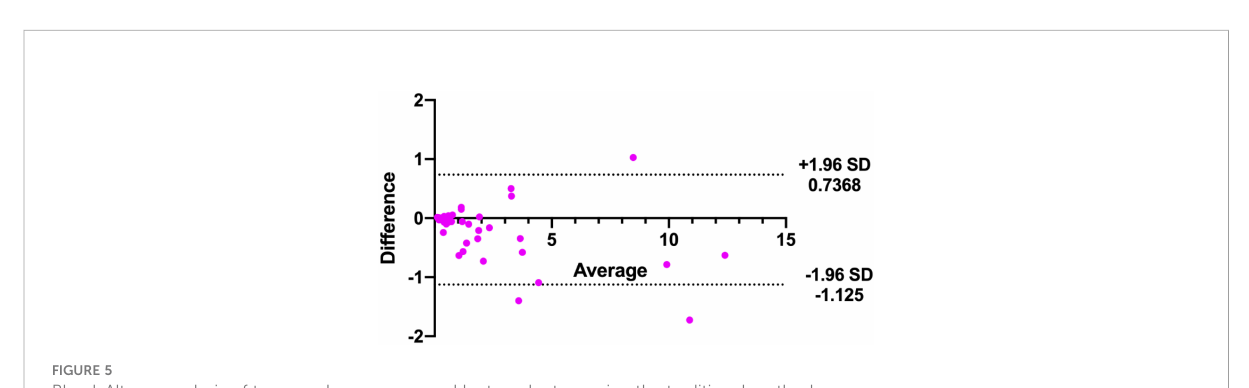
FIGURE 5 Bland-Altman analysis of tumor volumes measured by two doctors using the traditional method.